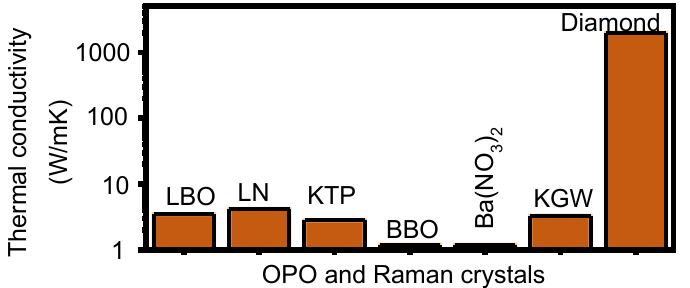
Figure 4. Thermal conductivity of common OPO and Raman gain crystals.